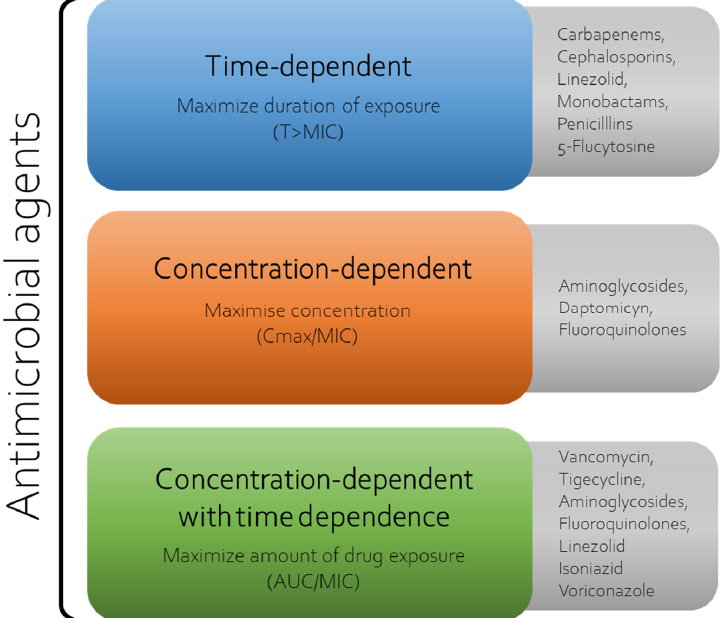
Figure 2. PK/PD classification of most common antimicrobial agents in intensive care units.